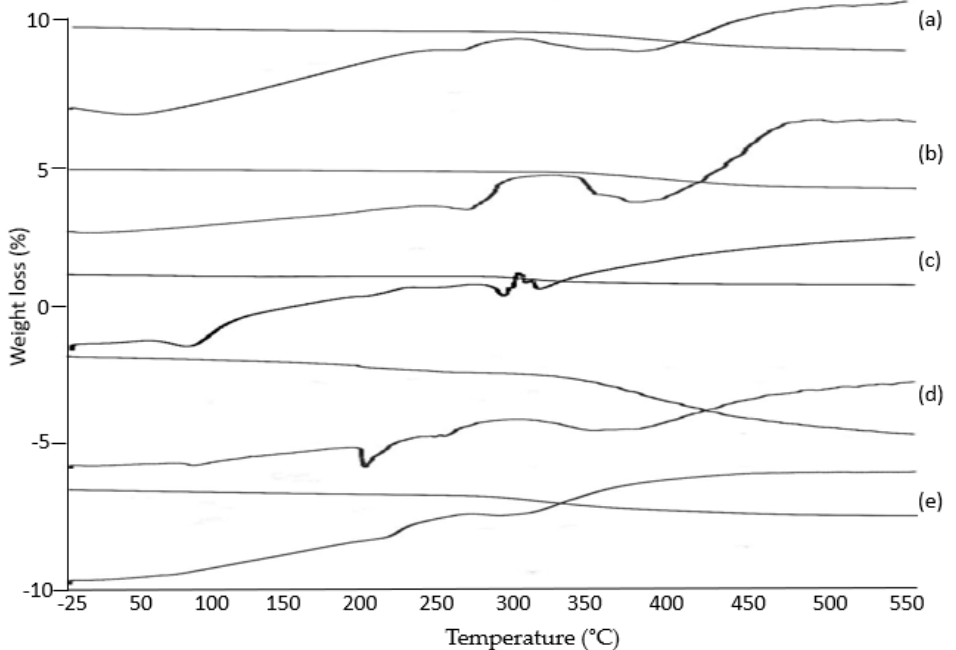
Figure 7. TGAspectraof( a )pureGel, ( b )purePVA,( c )MTX,( d )unloadedGel/PVAhydrogel, ( e Figure 7. TGA spectra of ( a ) pure Gel, ( b ) pure PVA, ( c ) MTX, ( d ) unloaded Gel/PVA hydrogel, ( e ) MTX-loaded Gel/PVA hydrogel.